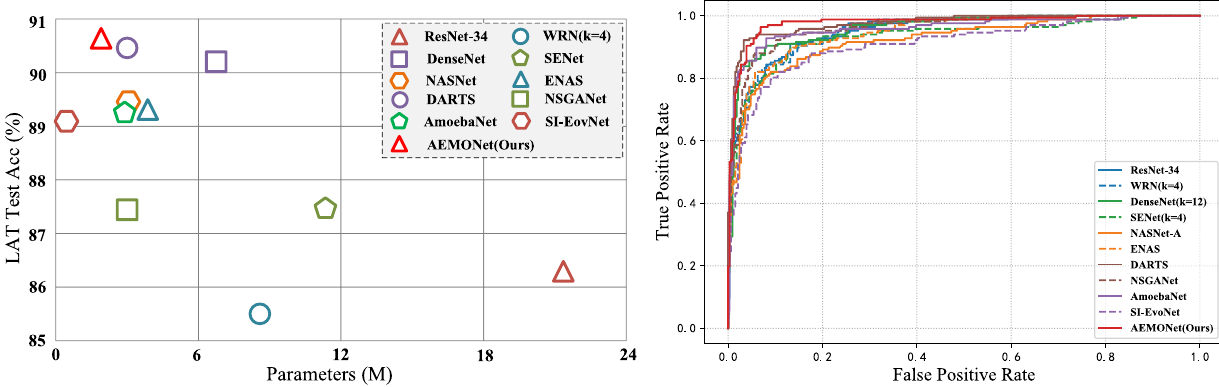
Fig. 13 left: the corresponding relationship between the number of parameters and the accuracy on LAT test set of all architectures; right: the receiver-operating characteristic curve (ROC) information of all architectures Fig. 14 Details of normal cells and reduction cells of the AEMONet achieved by the proposed AEMONAS on lambar spine dataset